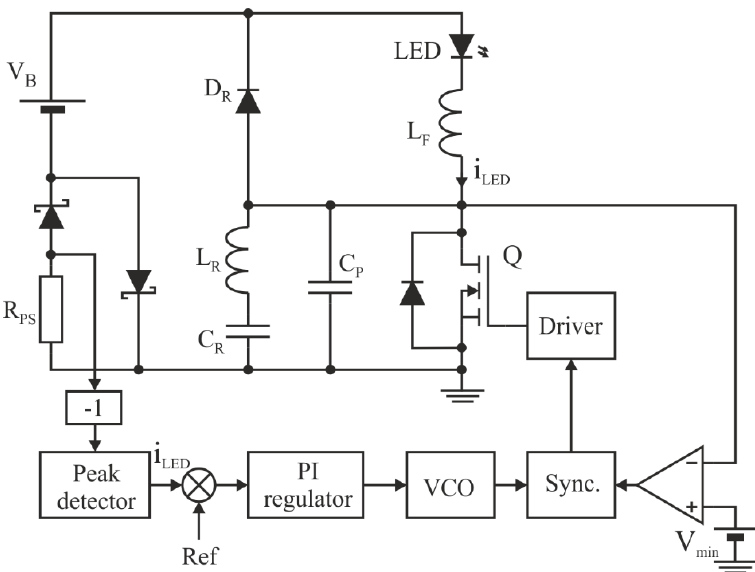
Figure 19. Simplified schematic of the control circuit.